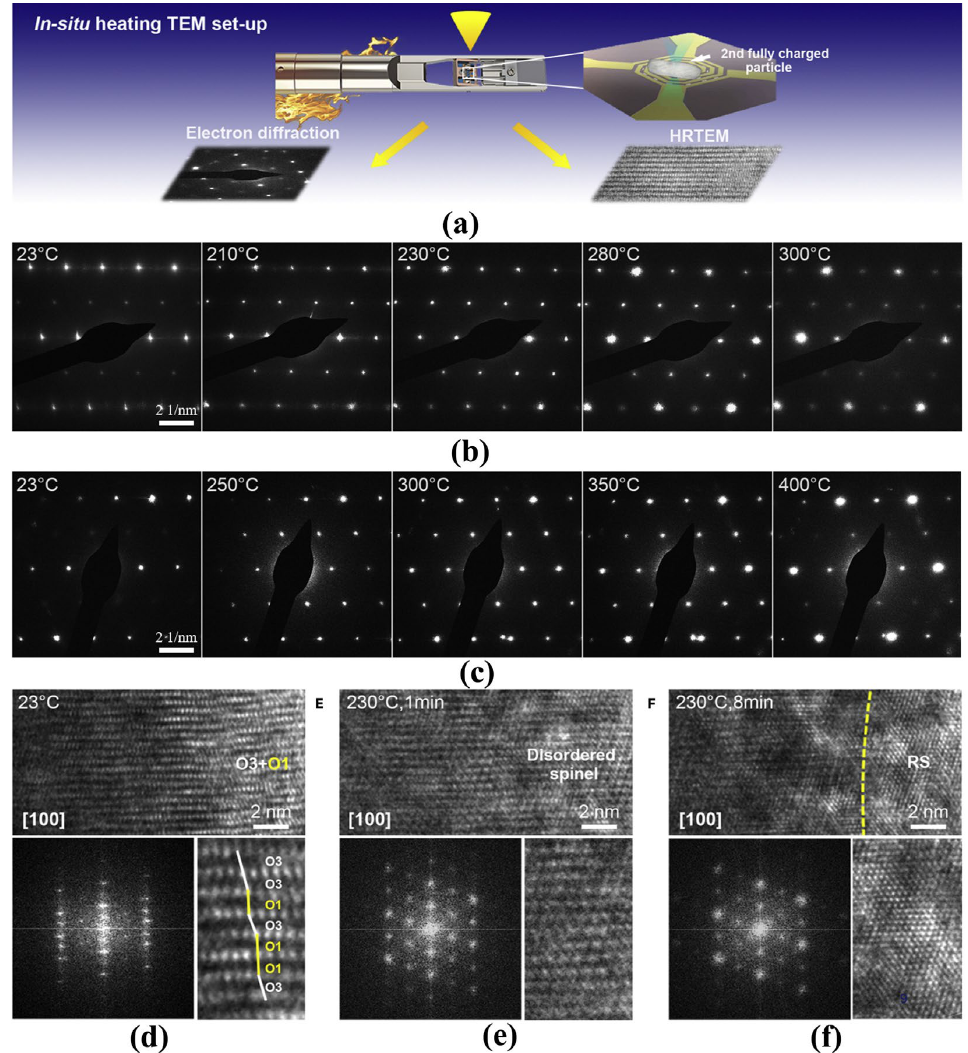
Figure 2. In situ structural evolution of delithiated LNO and doped LNO induced by oxygen loss. ( a ) Schematic illustration of the in-situ heating TEM experimental setup. ( b , c ) Time-resolved EDPs of LNO ( b ) and doped LNO ( c ) during in situ heating at different temperatures. ( d – f ) Time-resolved HRTEM images showing structural transformations of delithiated LNO from layered structure (O3) with O1 phases ( d ) to disordered spinel ( e ) and then to rock-salt structure ( f ) induced by oxygen loss during in situ heating. The lower panels show corresponding fast Fourier transforms and enlarged images of local regions. O3 and O1 phases are indicated by white and yellow lines, respectively [35].